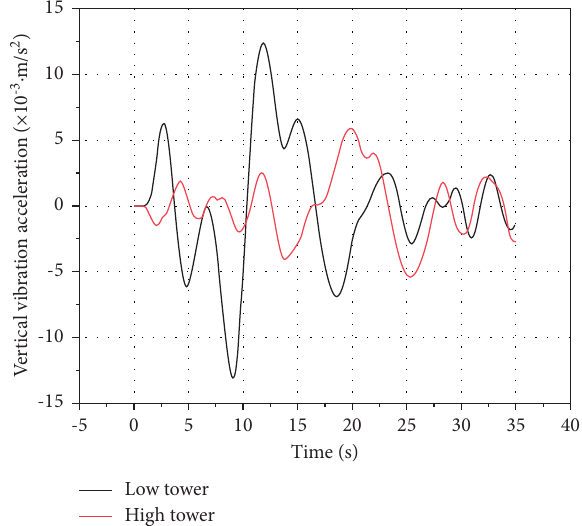
Figure 15: Comparison of vertical vibration acceleration time- history curves at L4 and